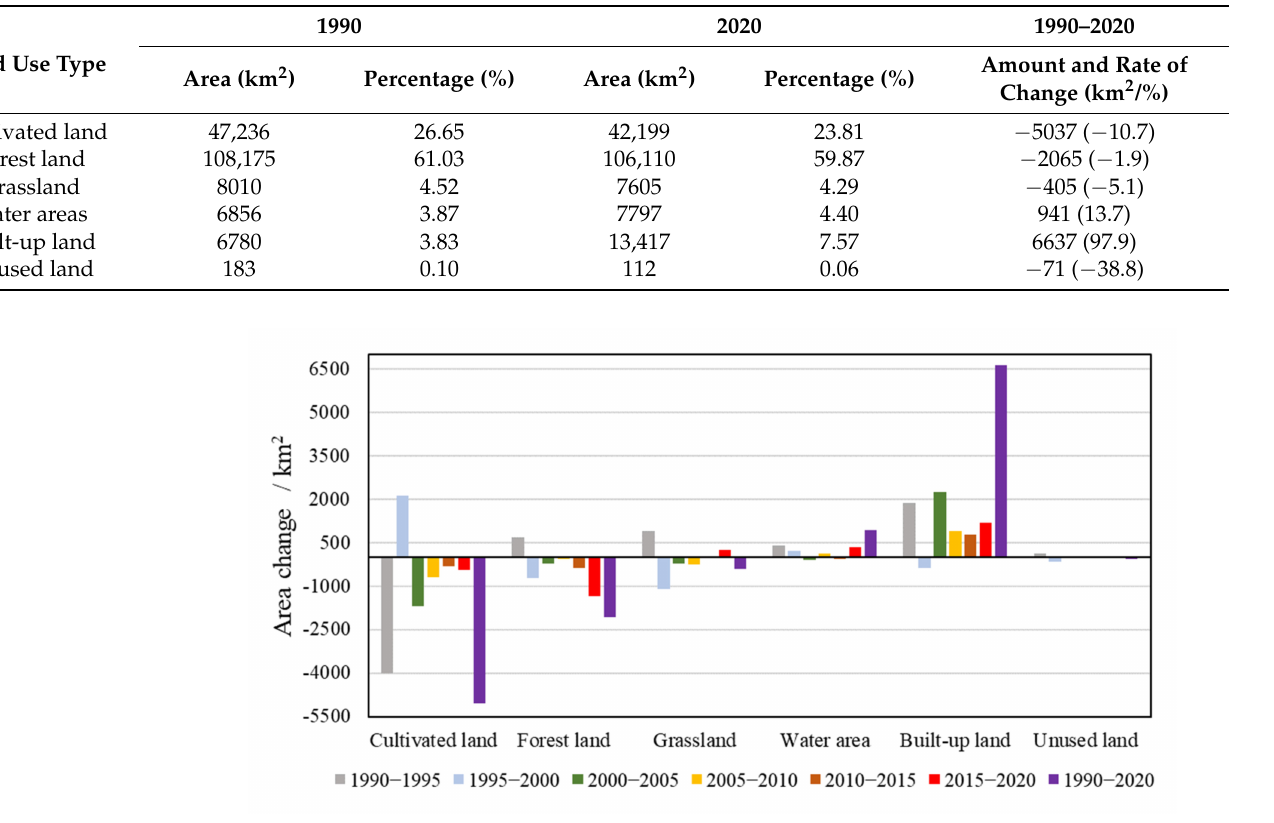
Table 3. Land use structure changes in Guangdong province, 1990–2020.